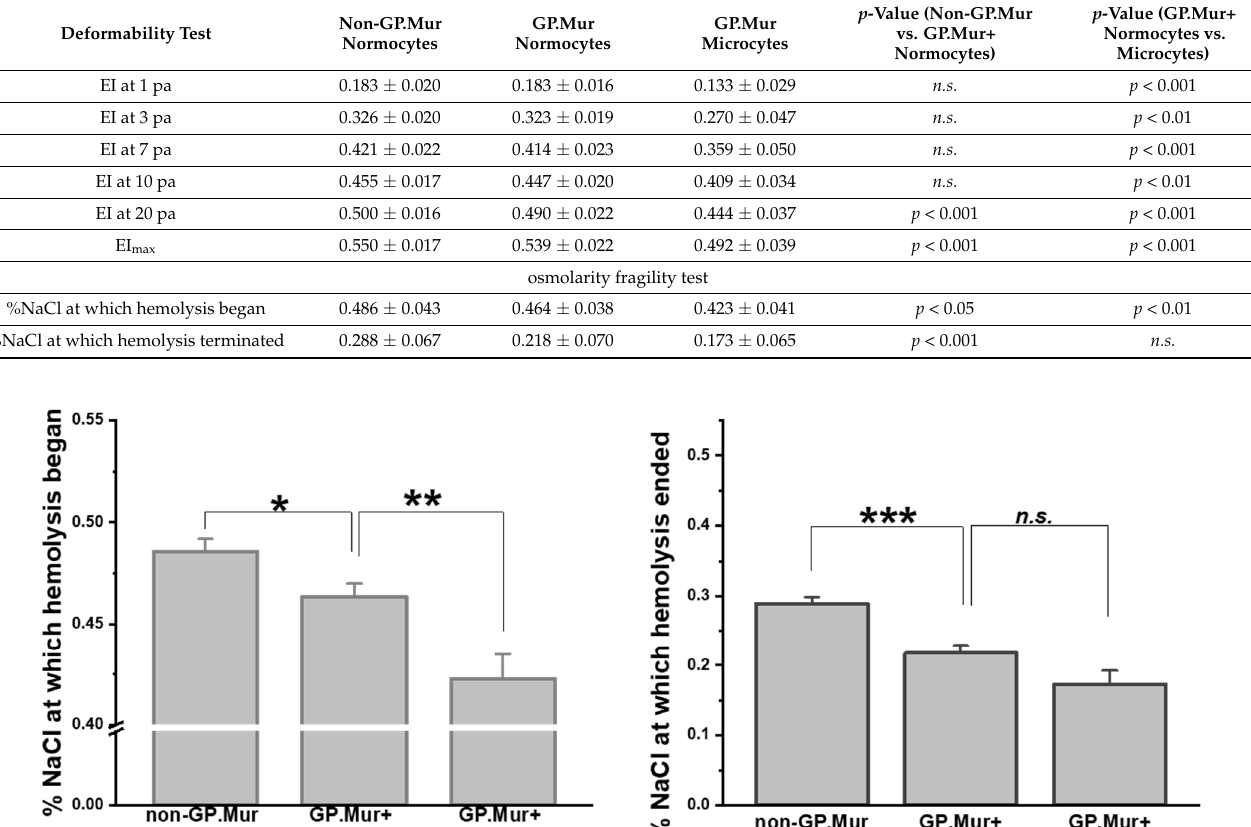
Table 2. The RBC deformability test results and the osmolarity fragility test results for GP.Mur-positive and GP.Mur-negative subjects.